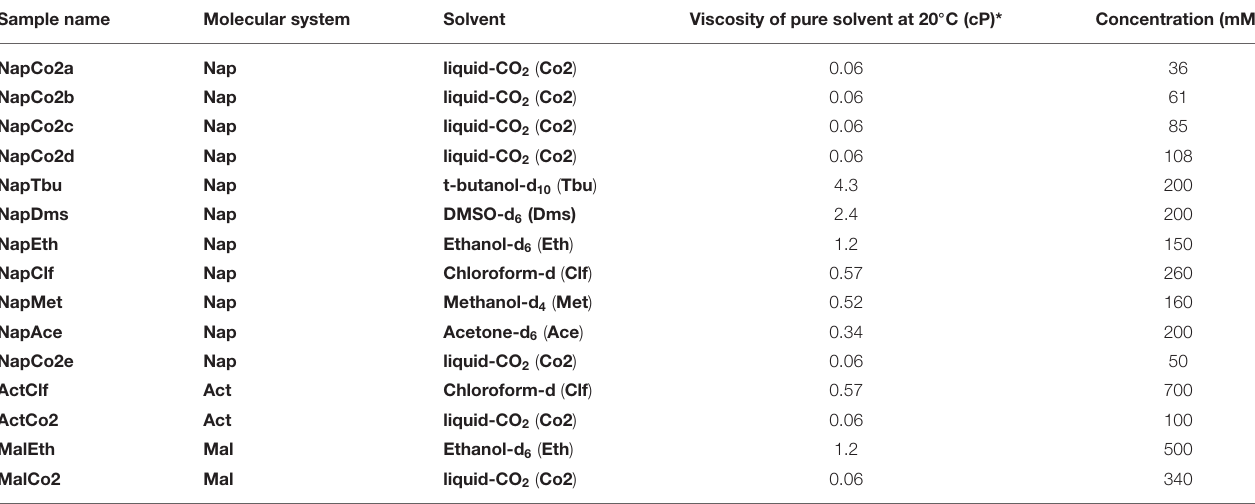
TABLE 1 | Nomenclature and preparation details of all samples used in the